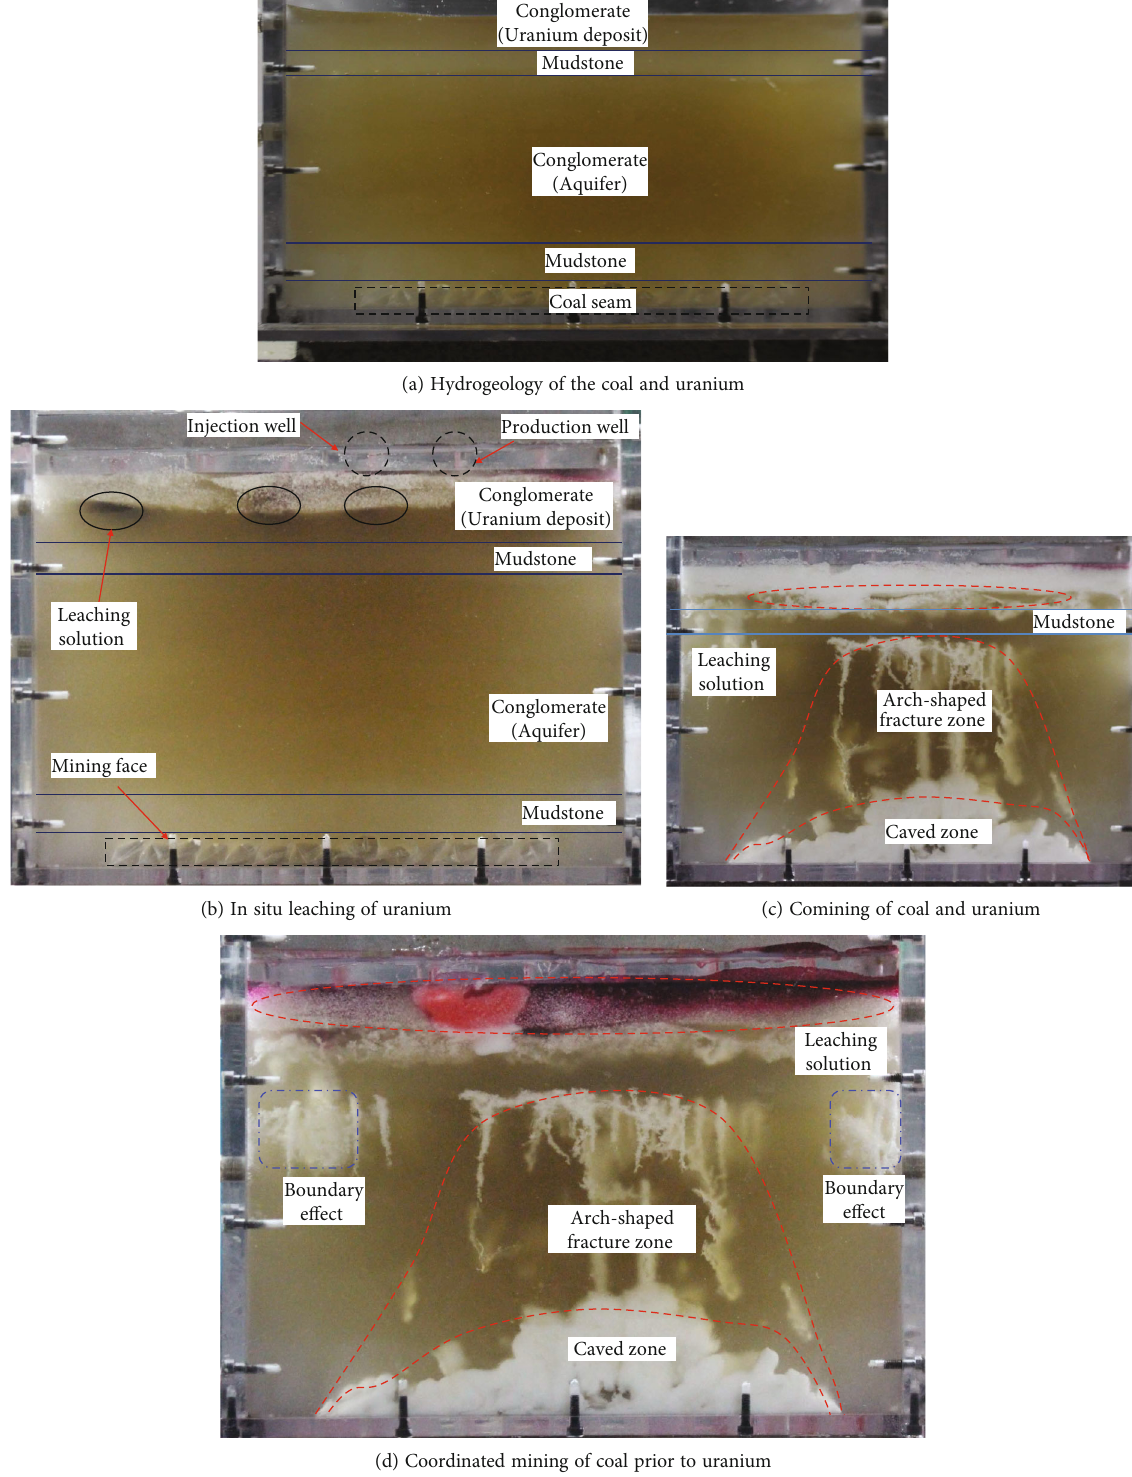
Figure 8: Development of the fracture and migration of leaching solution in di ff erent mining